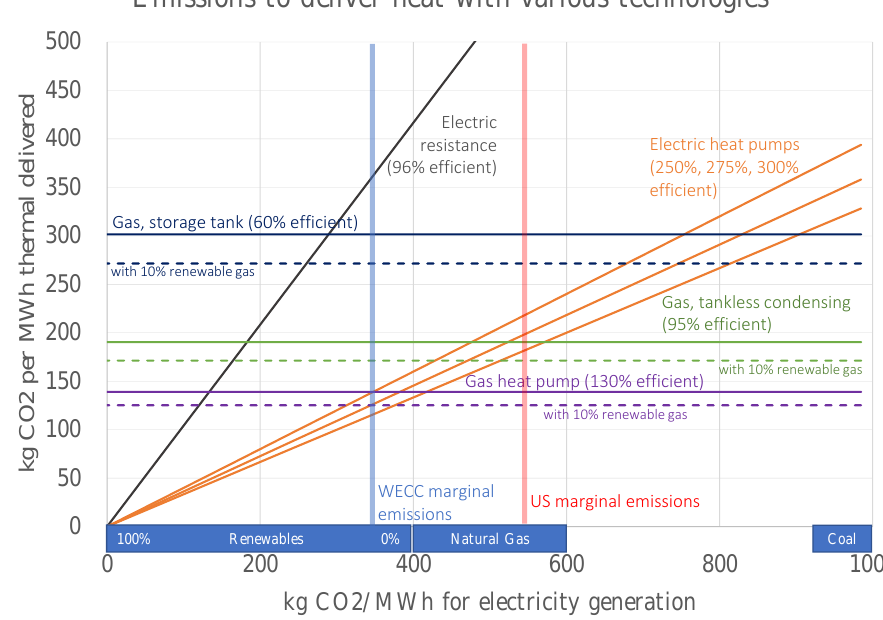
Figure 5. Emissions of various heating technologies as electricity emissions change.